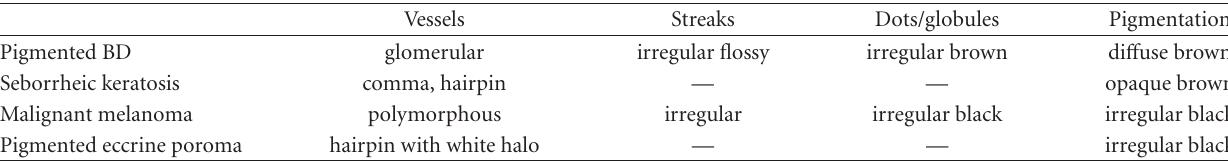
Table 2: Di ff erential diagnoses of pigmented BD on